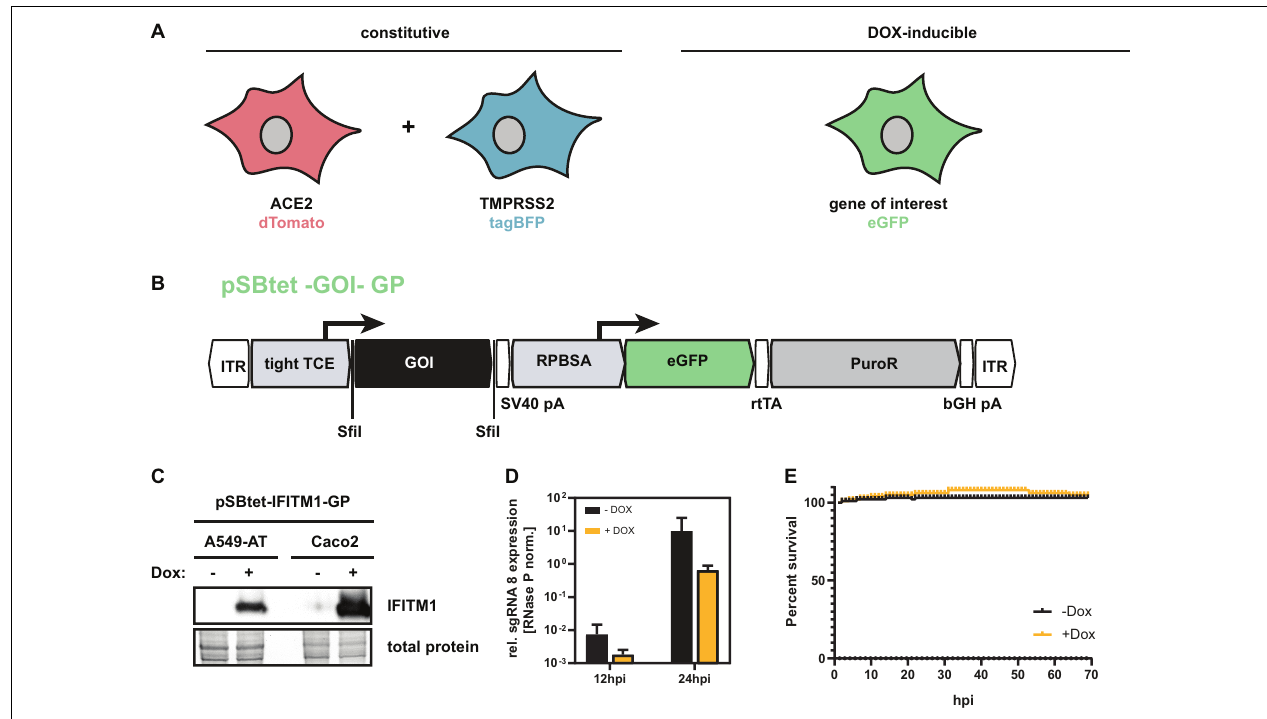
FIGURE 8 | Inducible overexpression of host factors in A549-AT cells. (A) Graphical overview of A549-AT cells constitutively expressing ACE2/dTomato (red), TMPRSS2/BFP (blue), and doxycycline inducible gene of interest (green). (B) Schematic drawing of plasmid pSBtet –GOI –GP including locations of open reading frames (ORFs), transcriptional start sites of the indicated promoters (tight TCE, RPBSA), inverted terminal repeats (ITR), polyadenylation signals (pA), Sfi I sites for cloning ( Sfi I), and the reverse tetracycline-controlled transactivator (rtTA). The ORF of the GOI is marked in black. The ORFs encoding eGFP is highlighted in green. The antibiotic resistance cassette encoding the puromycin resistance gene (PuroR) is indicated in gray. (C) Western blot analysis of A549-AT and Caco2 cells stably transfected with a FLAG-tagged IFITM1 encoding construct illustrated in B. (D) A549-AT cells overexpressing the host restriction factor IFITM1 were infected with SARS-CoV-2 and total cellular RNA was subjected to RT-qPCR analysis at the indicated time points ( n = 3). Relative expression of sgRNA 8 in Dox-induced or mock cells was used as surrogate marker for viral entry and active SARS-CoV-2 replication. (E) Cell viability of Dox and mock treated A549-AT cells was determined using a microplate reader with cell imaging and real time – cytometry. Cell viability was analyzed after doxycycline induction measuring cellular confluency.